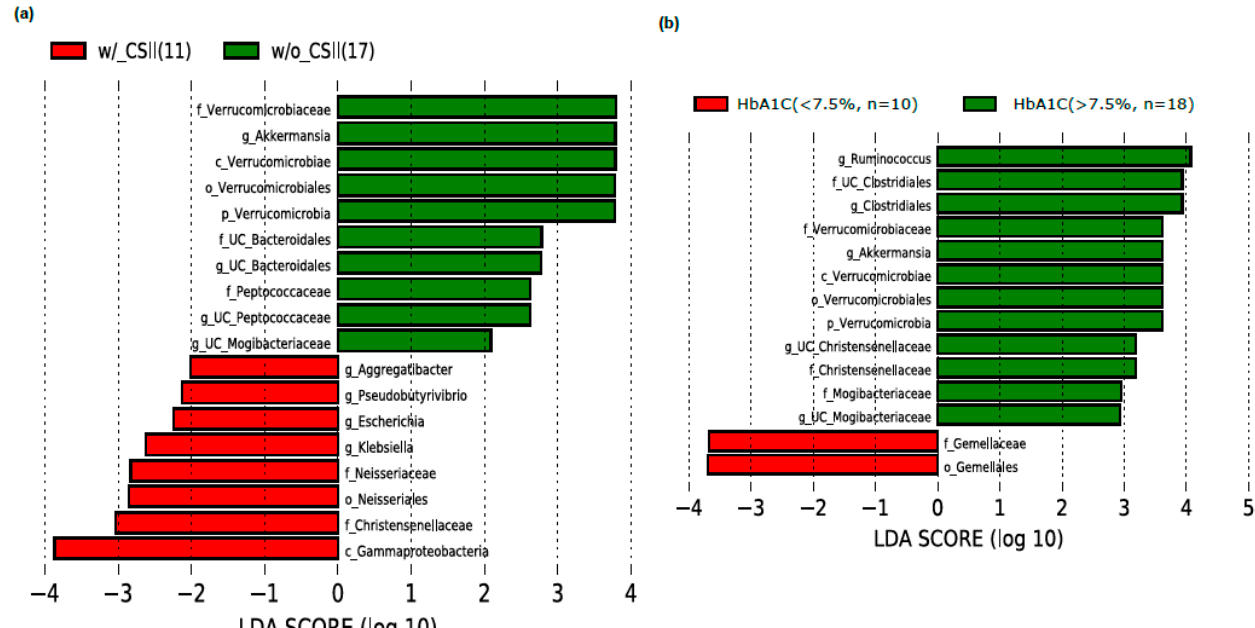
Figure 2. Effect of CSII therapy and HbA1C level on the gut microbiome composition in the T1DM subjects. The LEfSe analysis showed ( a ) significant enrichment of Akkermansia in the subjects without CSII therapy and ( b ) significant enrichment of Akkermansia in the subjects with HbA1c level of more than >7.5% and <7.5% LDA cutoff value >2.0. Note: g_UC, genus_unclassified.